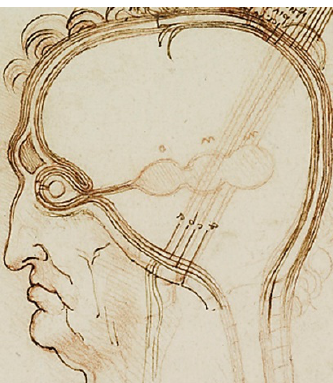
Fig. 1. “The Layers of the Scalp Compared with an Onion” (ca.1490- 1492). Still relying on the Cell Doctrine theory, Leonardo Drew the brain in pen and ink according to the accepted notion of three cells, while the rest of the head was drawn realistically [12] (Image courtesy of History of Science Collections, University of Oklahoma Libraries).